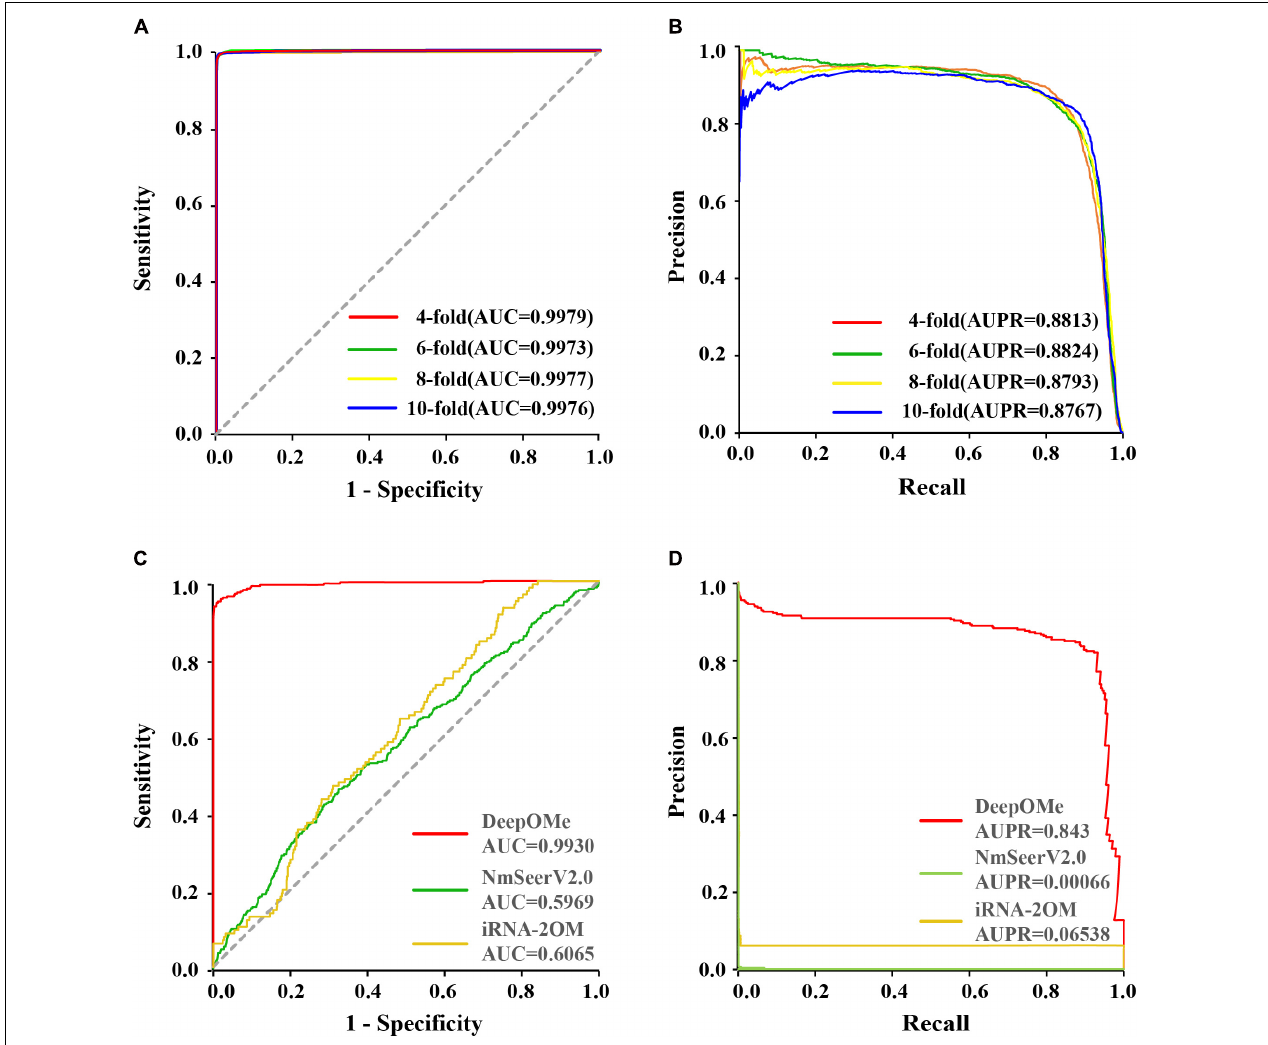
FIGURE 3 | Performance evaluation and comparison. The ROC (A) and PR (B) curves in 4-, 6-, 8-,10-fold cross-validation. The ROC (C) and PR (D) curves in testing set between DeepOMe, NmSEER V2.0 and